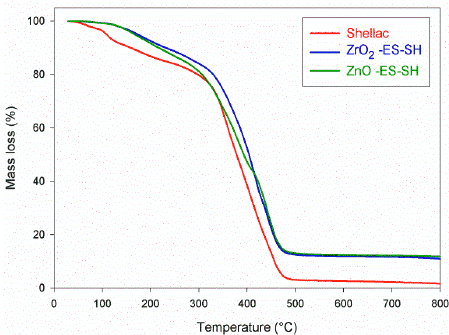
Figure 4. Thermogravimetric analysis profiles of plain shellac (SH) and of the nanocomposites ZnO-ES-SH and ZrO 2 -ES-SH.